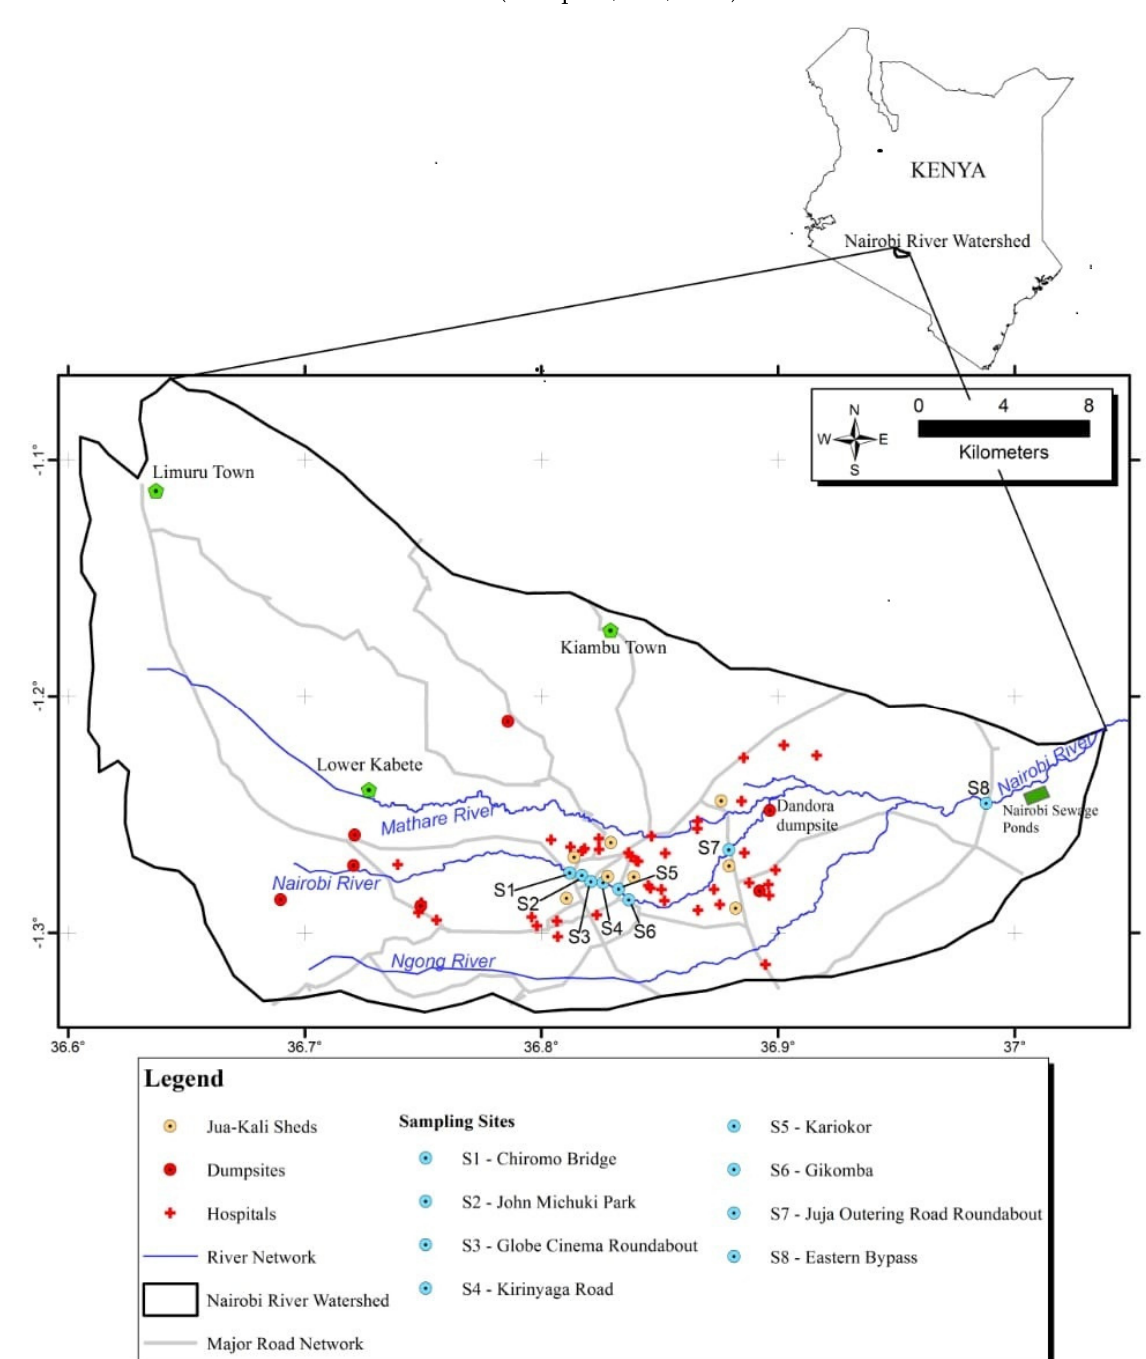
Figure 1. Study area and selected sampling points.